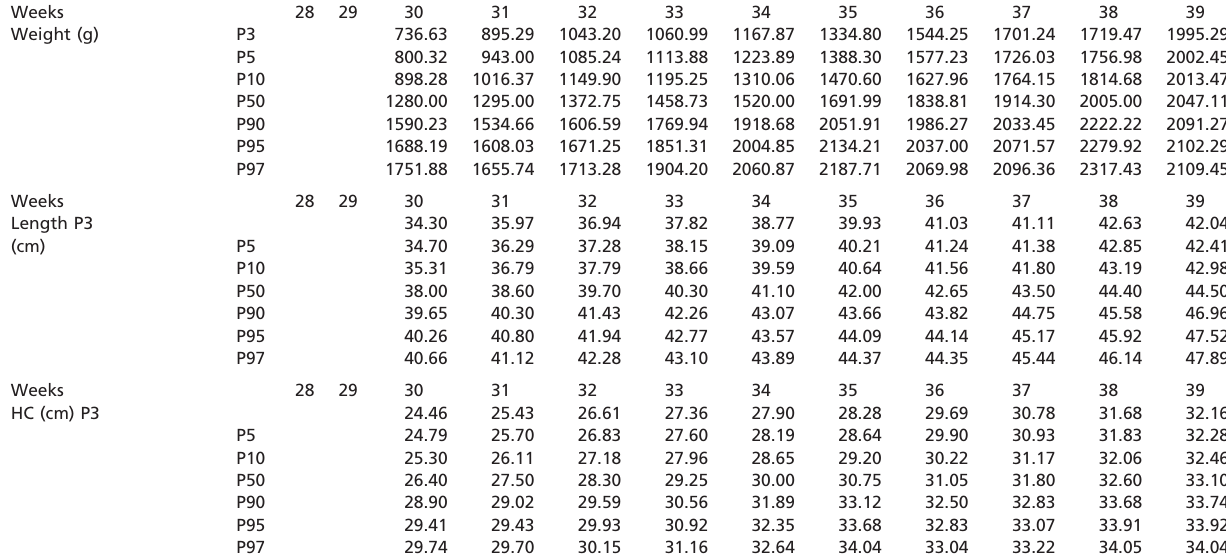
Table 3 - Evolution of Weight (w), Length (l) and Head Circumference (HC) percentiles (P3 to 97), according to the corrected gestational age, estimated through interpolation from the equation defined for each VLBWI of GI (n= 10). Weeks 28 29